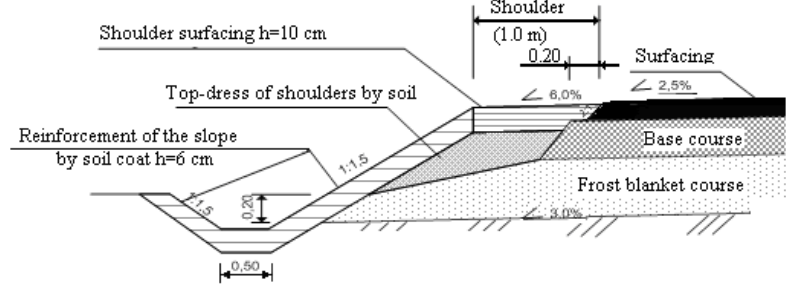
fig. 1. The structure of the low-volume road